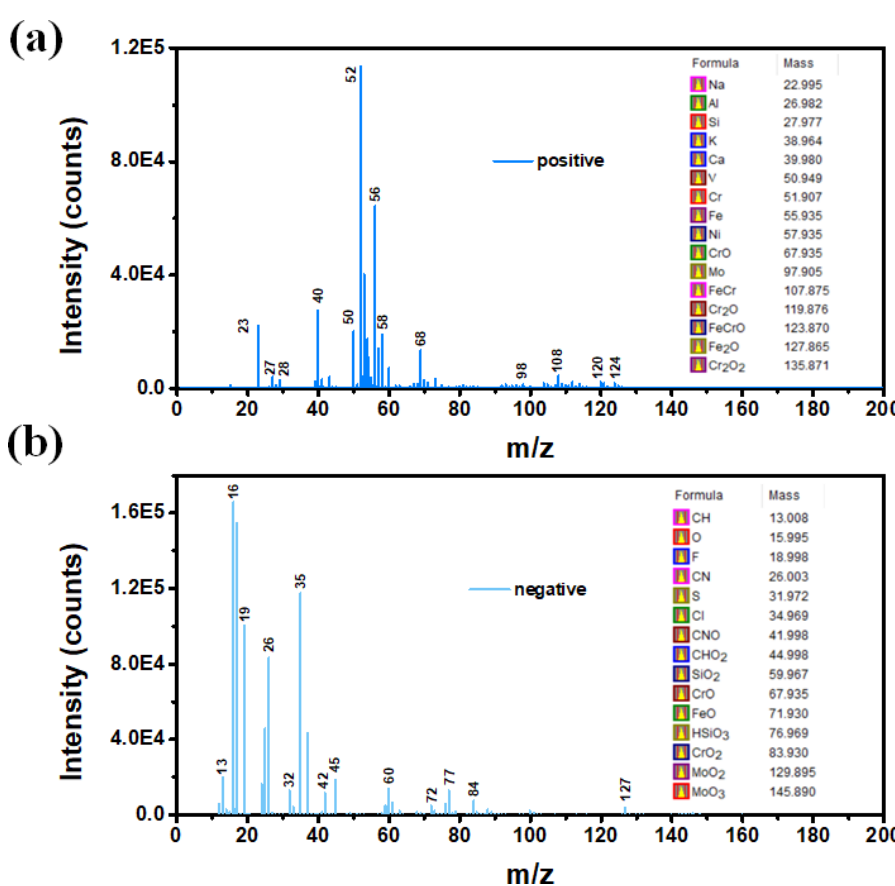
Figure 2. The mass spectra of the sample measured by ( a ) positive and ( b ) negative ion modes.